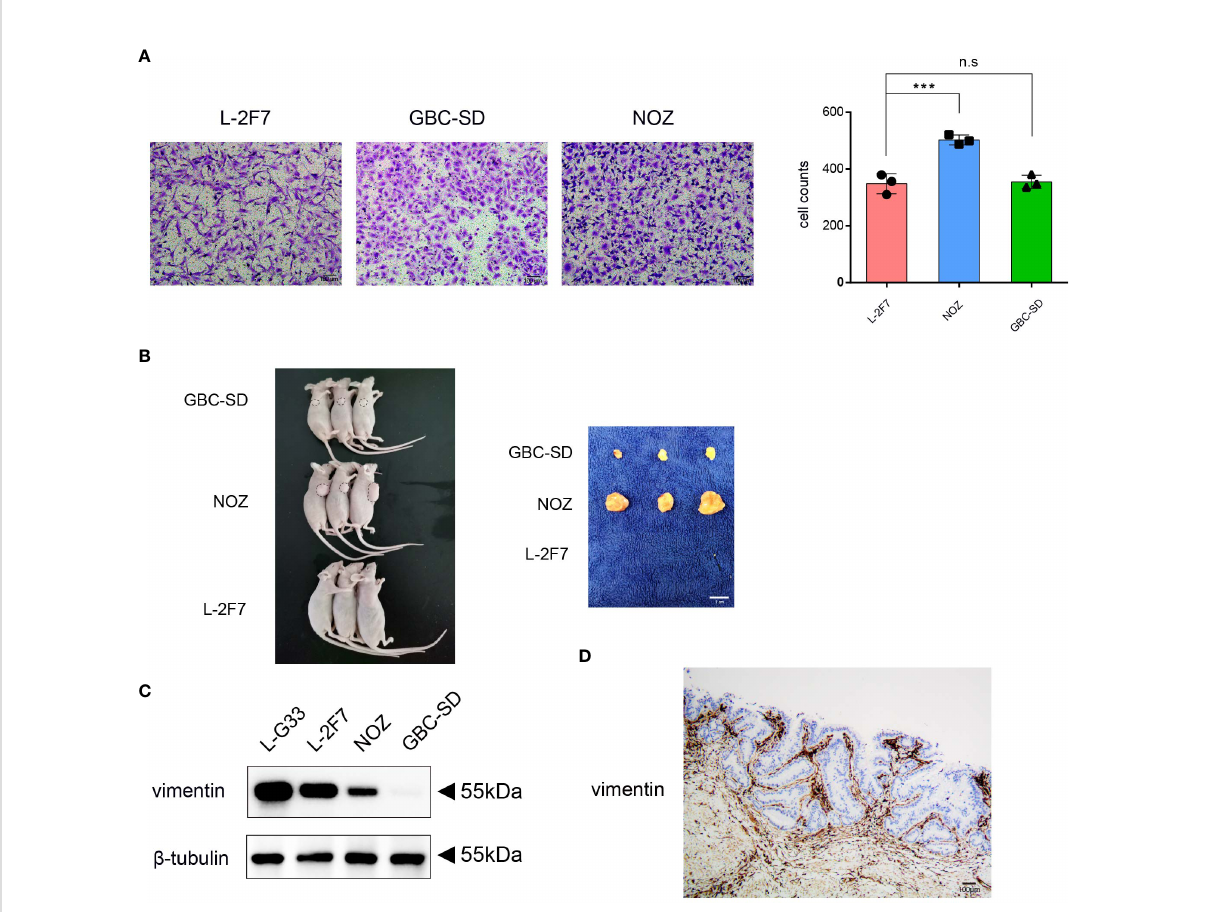
FIGURE 5 L-2F7 cells acquire motility but fail to develop cancer. L-2F7, NOZ, and GBC-SD cells were tested for their migration ability through Transwell assay, and the migrated cell counts were shown (A) . Each cell line (1 × 10 6 ) was subcutaneously injected to mice, and 3 weeks later, tumors were removed, n = 3 (B) . Expression of vimentin in L-G33, L-2F7, NOZ, and GBC-SD cells was evaluated through Western blot (C) . IHC staining of vimentin in normal gallbladder tissue was shown (D) . ***p < 0.001; **p < 0.01; *p < 0.05; n.s: non-signi fi